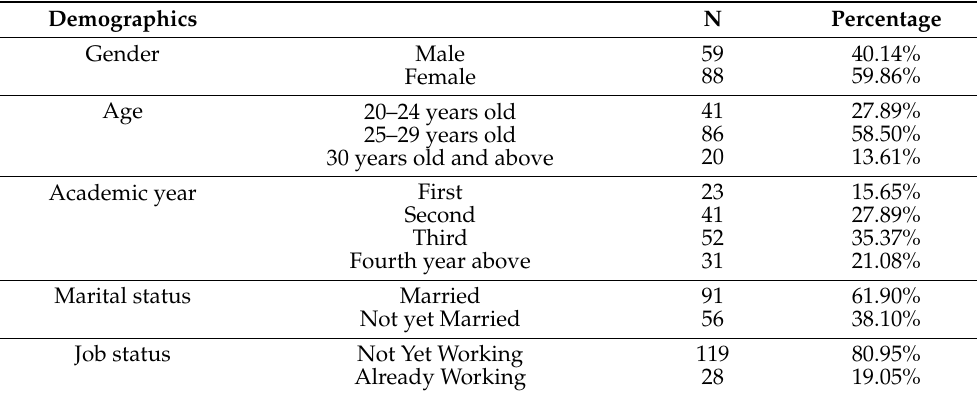
Table 2. Demographic information of